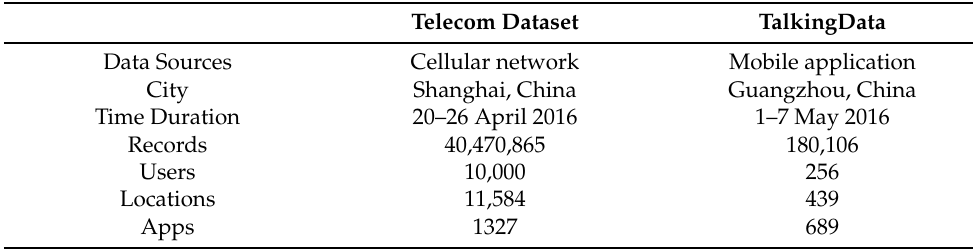
Table 1. Datasets and Statistics Information.